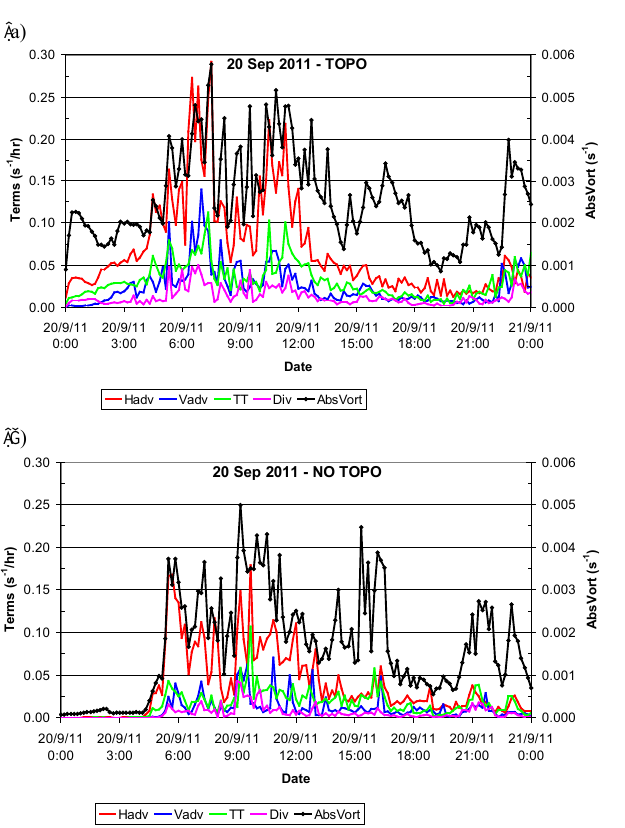
Figure 7. Similar to Fig. 5 but for the case of 20 September 2011.